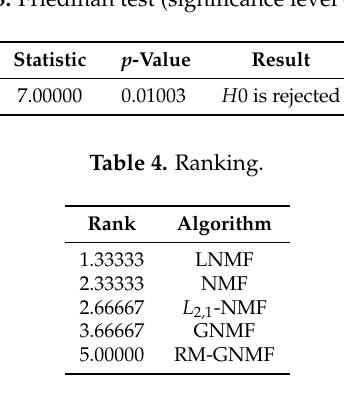
Table 3. Friedman test (significance level of 0.05).